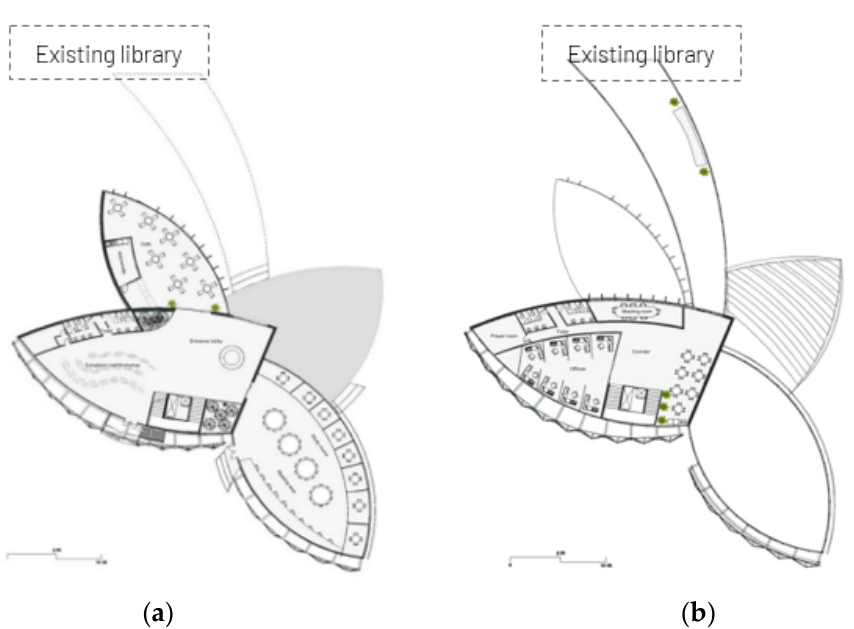
Figure 9. Floor plan with landscape.